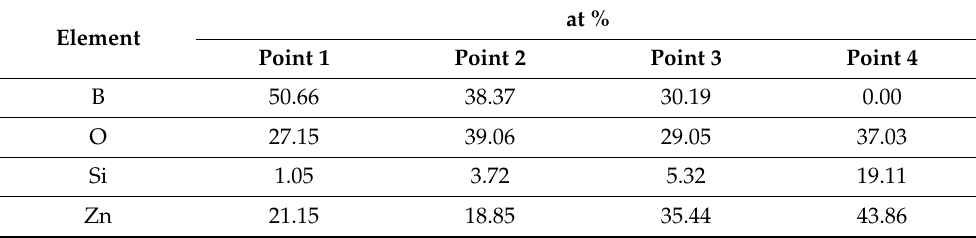
Figure 4. SEM images of fractured cross-sections of Zn 4 B 6 O 13 –Zn 2 SiO 4 composites: ( a ), ( b ), ( c ) 13% Zn 2 SiO 4 , sintered at 930°C, ×5000, ×10,000, ×20,000, ( d ) 20% Zn 2 SiO 4 , ×10,000, sintered at 930 °C, ( e ) 50% Zn 2 SiO 4, sintered at 950 °C, ×20,000, marked points 1–4 of EDS analysis, ( f ) 60% Zn 2 SiO 4 , sin- tered at 950 °C, ×10,000. Table 2. Results of EDS analysis at the points marked in Figure 4e for 50% Zn 4 B 6 O 13 –50% Zn 2 SiO 4 ceramic sintered at 950 °C.